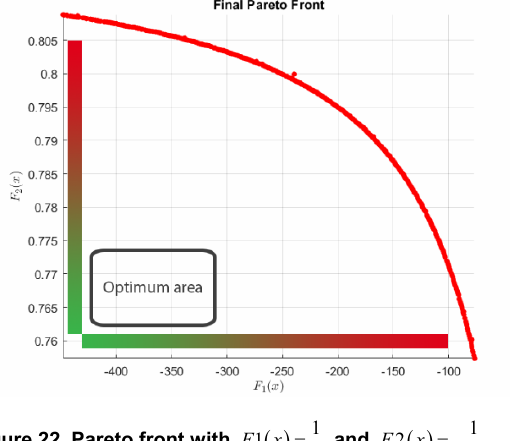
Figure 22. Pareto front with